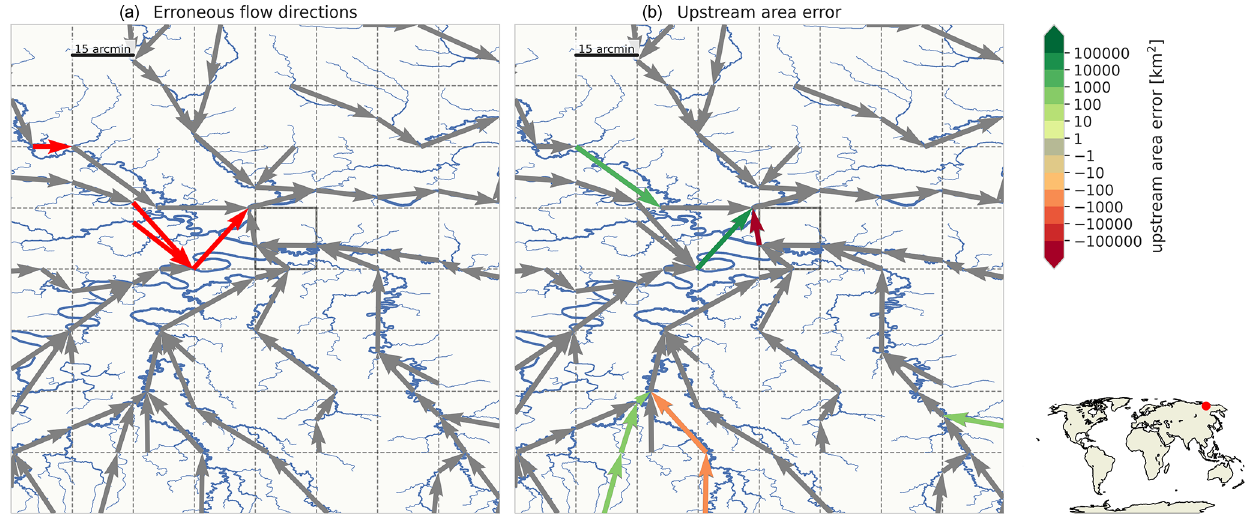
Figure C6. Second-largest local upstream area error ( − 220876km 2 ) at the 15arcmin resolution indicated with a highlighted cell. See the caption of Fig. C1 for a full